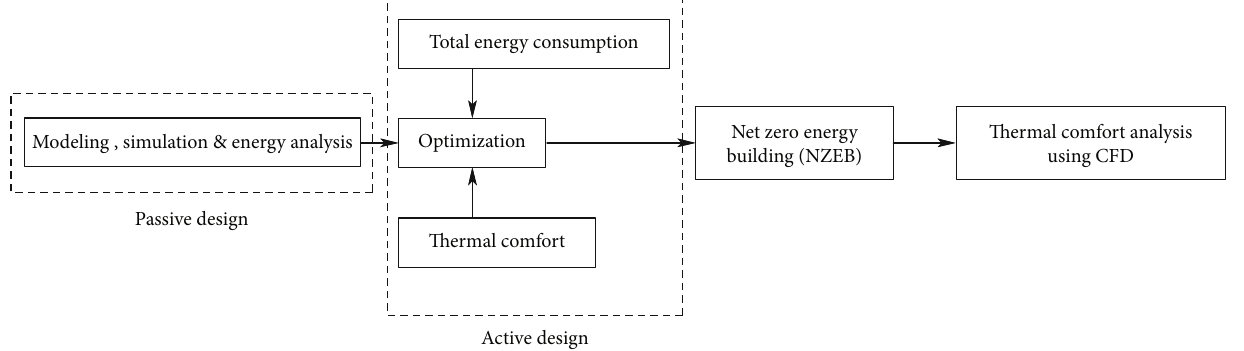
Figure 2: The analysis and problem solving strategies.